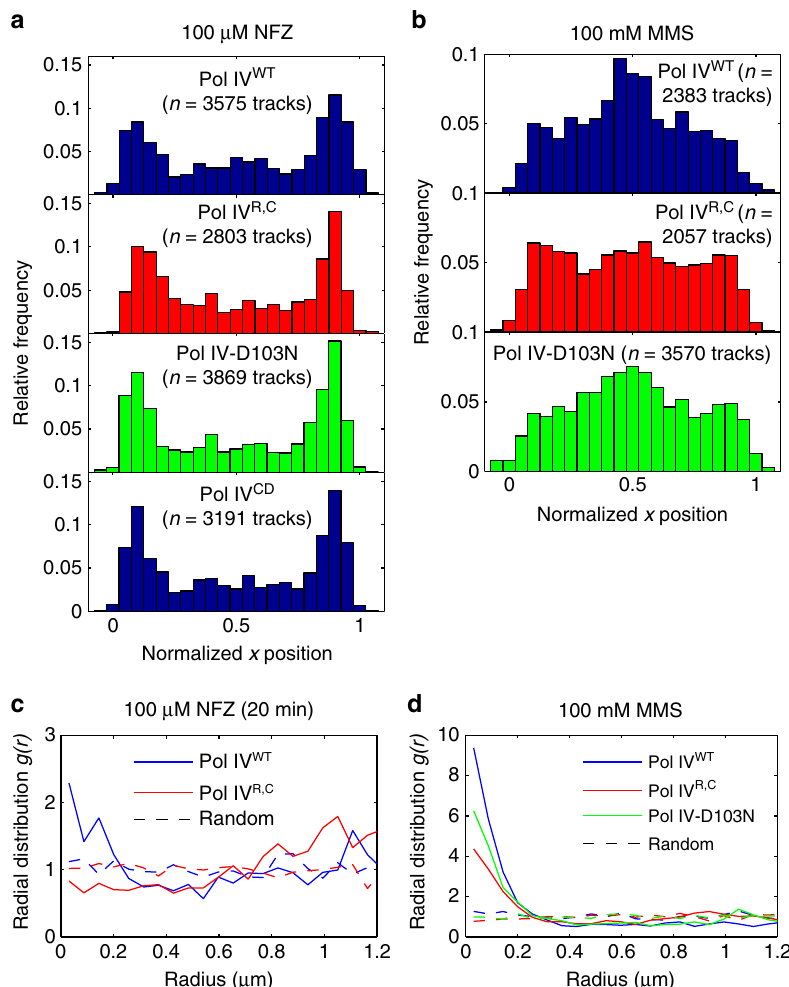
Fig. 5 Long-axis cellular localization pro fi les and single-cell colocalization analysis of Pol IV mutants. a Long-axis cellular localization of Pol IV WT and the Pol IV R,C , Pol IV-D103N, and Pol IV CD mutants in cells treated with 100 µ M NFZ. b Long-axis cellular localization of Pol IV WT and the Pol IV R,C and Pol IV- D103N mutants in cells treated with 100 mM MMS. c Radial distribution functions g(r) for Pol IV WT and the Pol IV R,C mutant in cells treated with 100 µ M NFZ for 20 min. d Radial distribution functions g(r) for Pol IV-SSB distance for Pol IV WT and the Pol IV R,C and Pol IV-D103N mutants in cells treated with 100 mM MMS. Also shown in panels c and d are random g(r) functions for each data set. The Pol IV WT data in a – d are replotted from Fig. 2c, e and Fig.